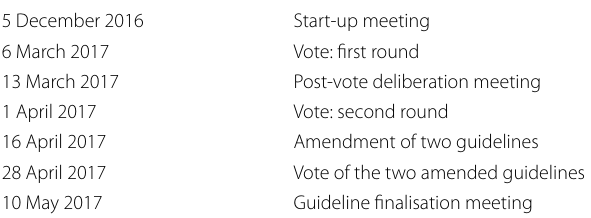
Table 1 Criteria for defining pneumonia